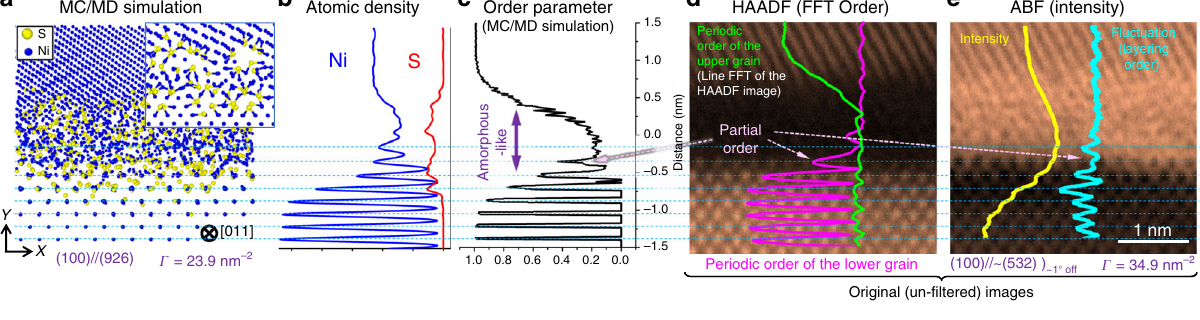
~ V S ! Ni vectors sum